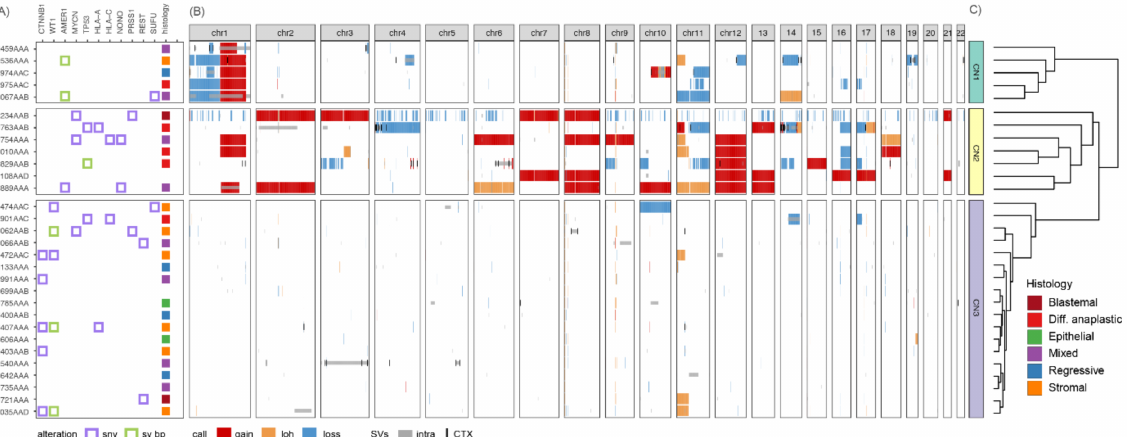
Figure 1. Copy number profiles cluster tumors into three groups reflecting different degrees of genomic instability. Unsupervised analysis of copy number (CN) data identified three clusters of tumors with distinct genome-wide CN patterns. Tumors that have co-occurring 1p loss and 1q gain (CN1), multiple chromosomal gains (CN2) or that are copy number neutral (CN3). ( A ) Oncoplot with cancer genes recurrently altered by SNVs (purple) or disrupted by SV breakpoints (green). Genes are ordered by the number of tumors they are mutated in. Tumors are annotated by their histological subtype. ( B ) Genome-wide CN profiles with gains (red), losses (blue) and copy number neutral loss-of-heterozygosity (gold), overlain by SVs with translocations (black lines) and intrachromosomal variants (gray). ( C ) Dendrogram resulting from hierarchical clustering of the CN